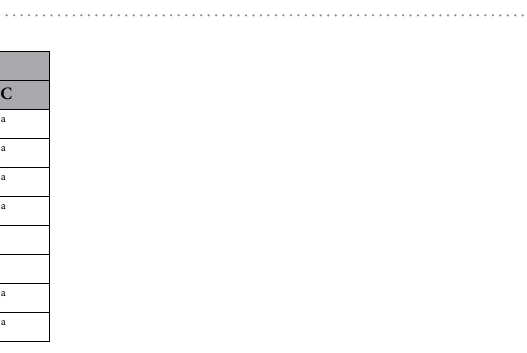
Figure 3. Effect of temperature on the activity of wild-type xylanase and its mutants. The purified xylanases were treated at temperatures ranging from 20 °C to 80 °C with Na 2 HPO 4 -citric acid buffer for 20 min and then assayed at optimum conditions. ■ , wild-type xylanase; ● , T53C-T142C; ▲ , T46P; ♦ , S136P; □ , T53C-T142C/ T46P; ○ , T53C-T142C/S136P; ∆ , T46P-S136P; ◊ , T53C-T142C/T46P/S136P.